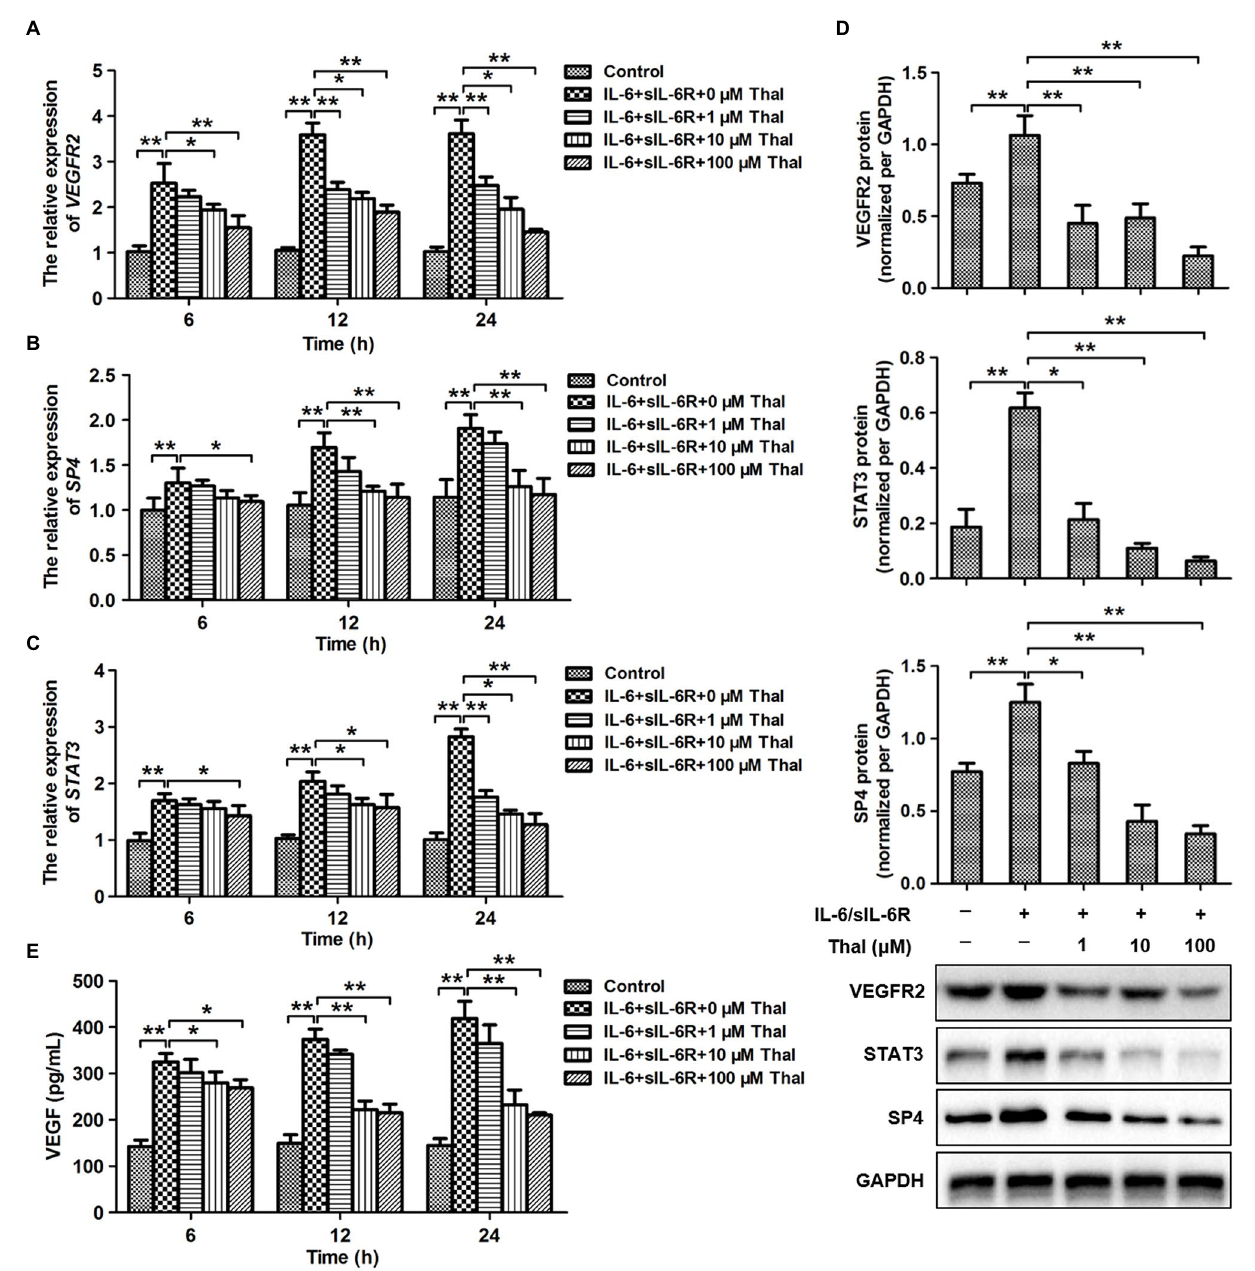
FIGURE 1 | Effect of thalidomide on the expression of VEGFR2, SP4, and signal transducer and activator of transcription 3 (STAT3) in human peritoneal mesothelial cells (HPMCs) treated with a combination of IL-6 and soluble IL-6 receptor (sIL-6R). (A–C) quantitative real-time PCR (qRT-PCR) analyses were performed to evaluate the expression of VEGFR2, SP4, and STAT3 in HPMCs treated with IL-6 + sIL-6R (both at 100 ng/ml) at three time points (6, 12, and 24 h) in the presence of thalidomide at dose concentrations of 0, 1, 10, and 100 μ M. (D) The western blot results showed that the protein levels of VEGFR2, SP4, and STAT3 changed in HPMCs treated with IL-6 + sIL-6R (both at 100 ng/ml) at 48 h in the presence of thalidomide at dose concentrations of 0, 1, 10, and 100 μ M. For the quantitative analysis of VEGFR2, SP4, and STAT3 protein levels, the target protein expression was normalized to that of glyceraldehyde 3-phosphate dehydrogenase (GAPDH). (E) The intracellular content of vascular endothelial growth factor (VEGF) from enzyme linked immunosorbent assay (ELISA). * p < 0.05; ** p < 0.01. Thal,